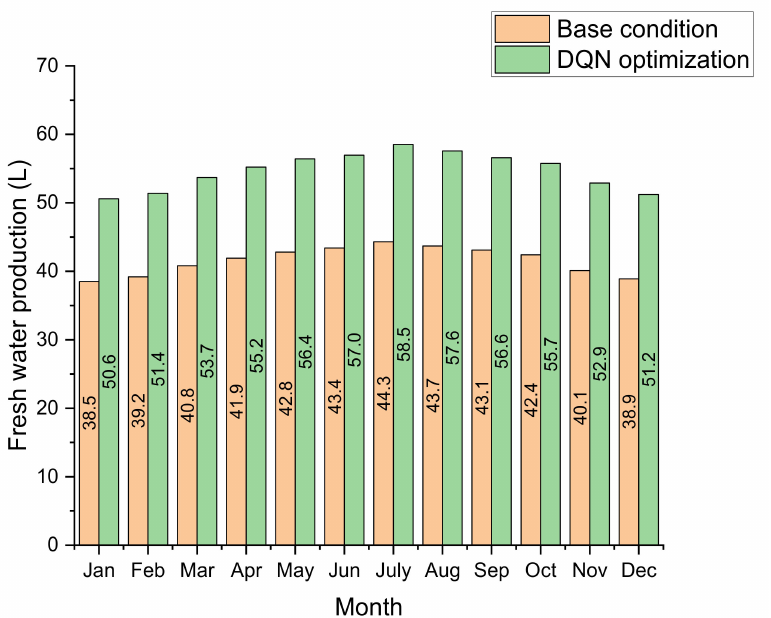
Figure 9. The efficiency of the solar still with nanofluids optimized by DQN and the solar still with water.